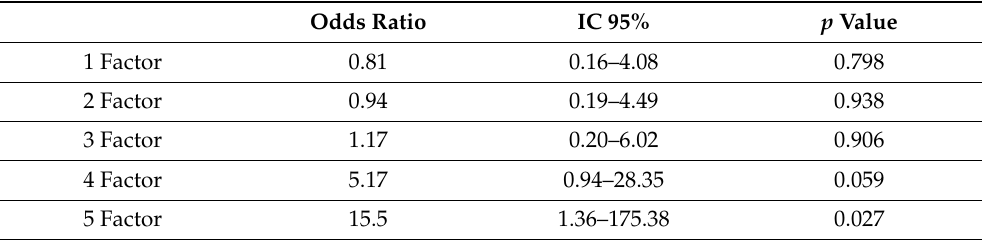
Table 3. Association to C16223T mtDNA depending on the presence of classical cardiovascular risk